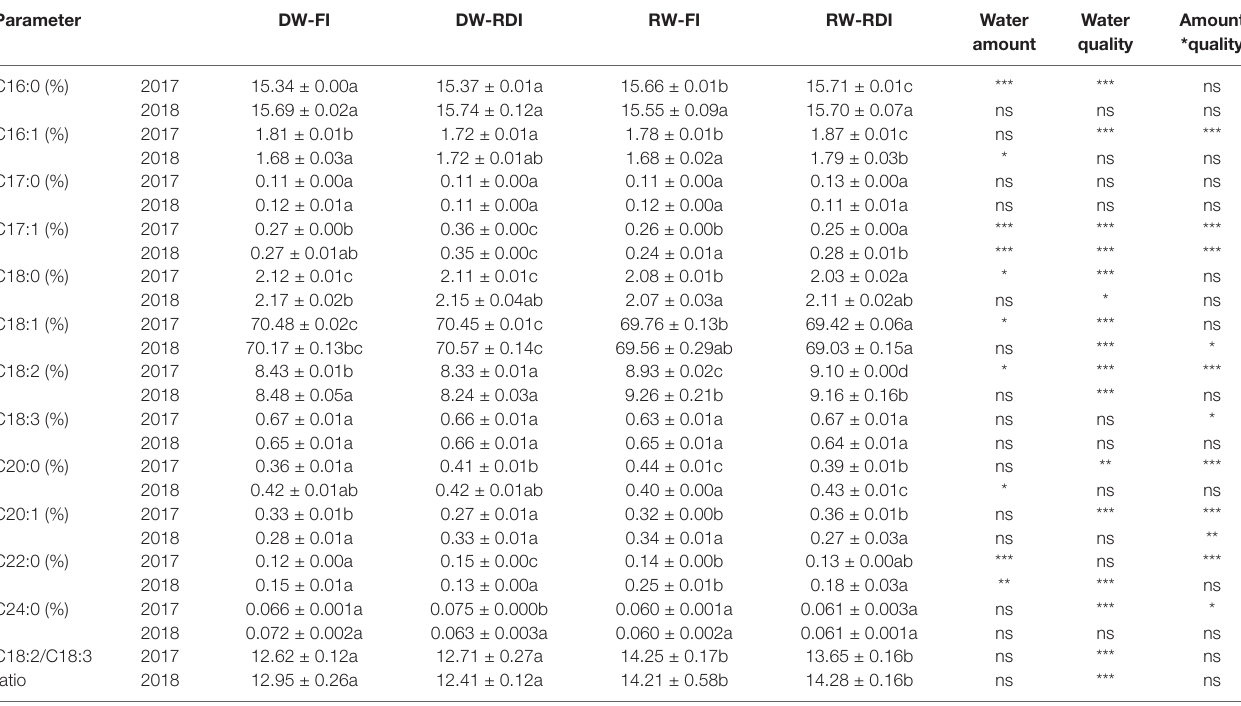
Different letters within the same row indicate significant differences among treatments for the different parameters and year according to Tukey’s Test (*p < 0.005 ; **p < 0.01; ***p < 0.005). ns, not